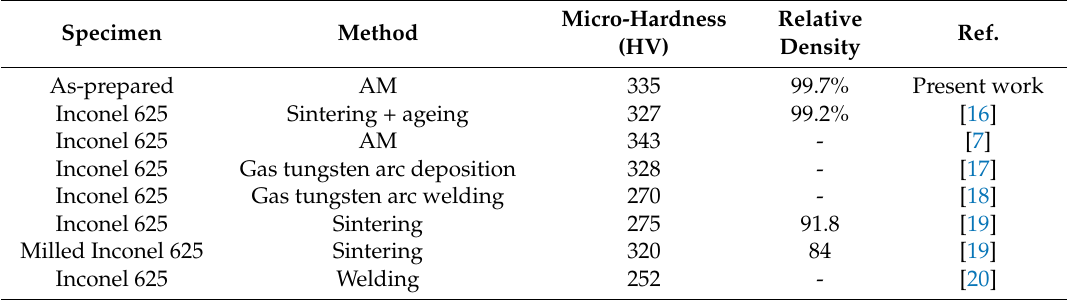
Table 2. Micro-hardness and relative density of the as-prepared specimen and other Inconel 625 alloys fabricated by different